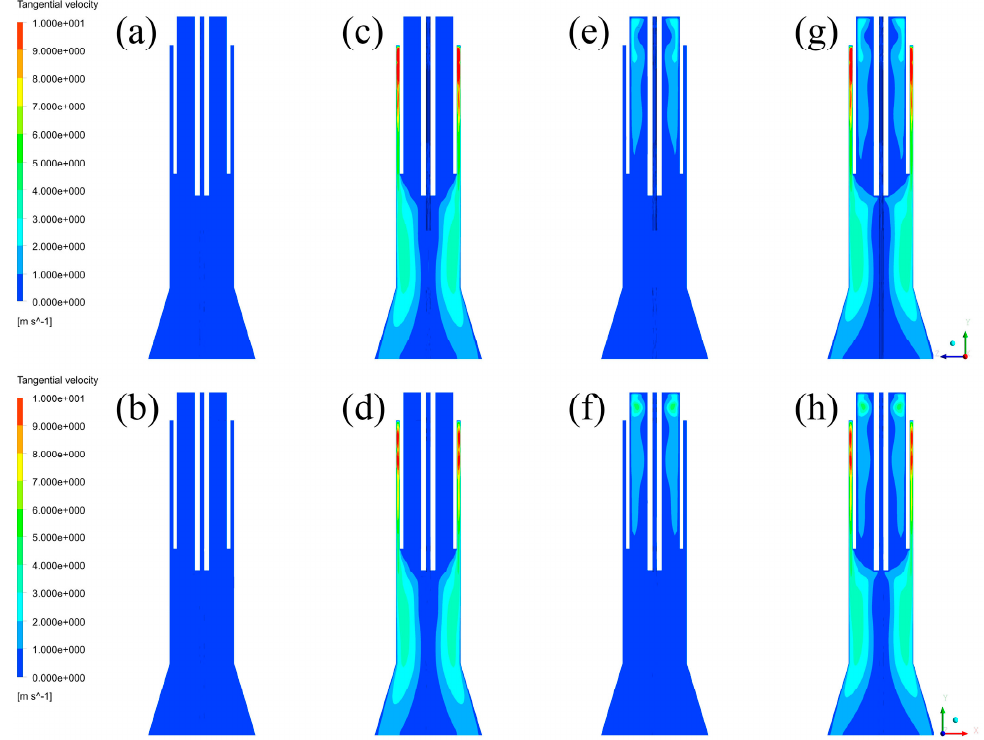
Figure 6. Tangential velocity fields: ( a ) Case A in YZ plane, ( b ) Case A in XZ plane, ( c ) Case B in YZ plane, ( d ) Case B in XZ plane, ( e ) Case C in YZ plane, ( f ) Case C in XZ plane, ( g ) Case D in YZ plane, ( h ) Case D in XZ plane.